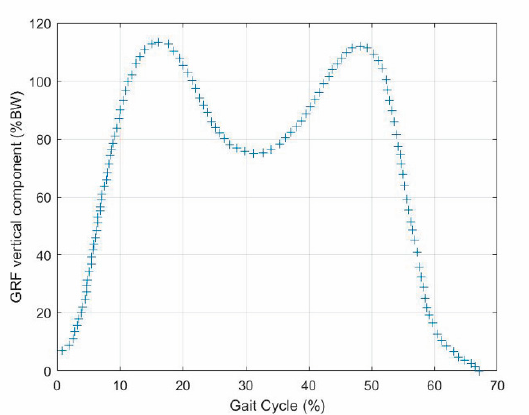
Figure 2 . Ground reaction force (GRF) vertical component in percentage of body weight (BW) as a function of the gait-cycle percentage obtained from the dataset reported in [18].